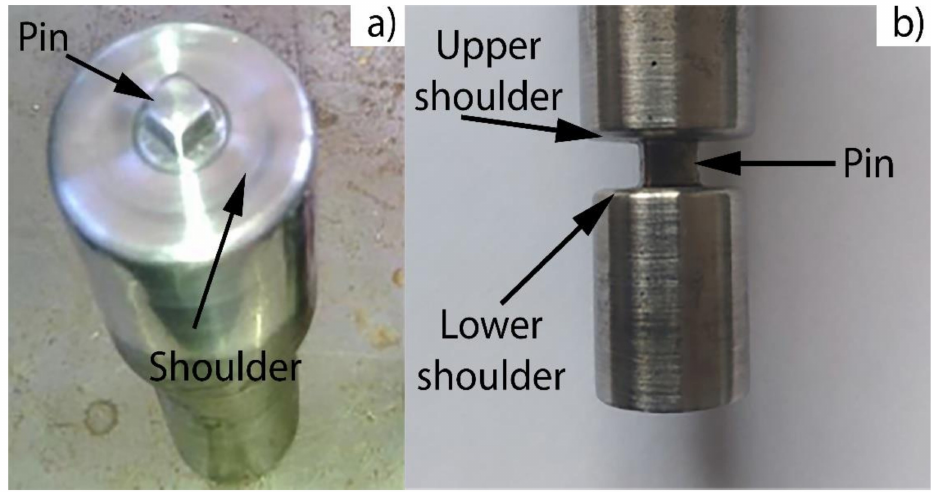
Figure 2. FSW tools: ( a ) conventional FSW tool; ( b )